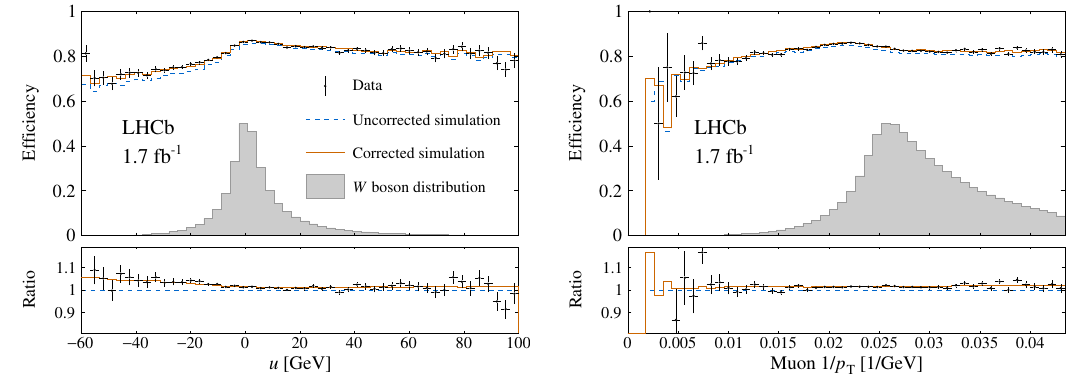
Figure 5 . Isolation efficiencies as a function of the observables (left) u and (right) 1 /p T of the muon. The grey histograms indicate the, arbitrarily normalised, shapes of each distribution in simulated W boson events. In the lower panels the ratios of the isolation efficiency with respect to the uncorrected simulation are shown.